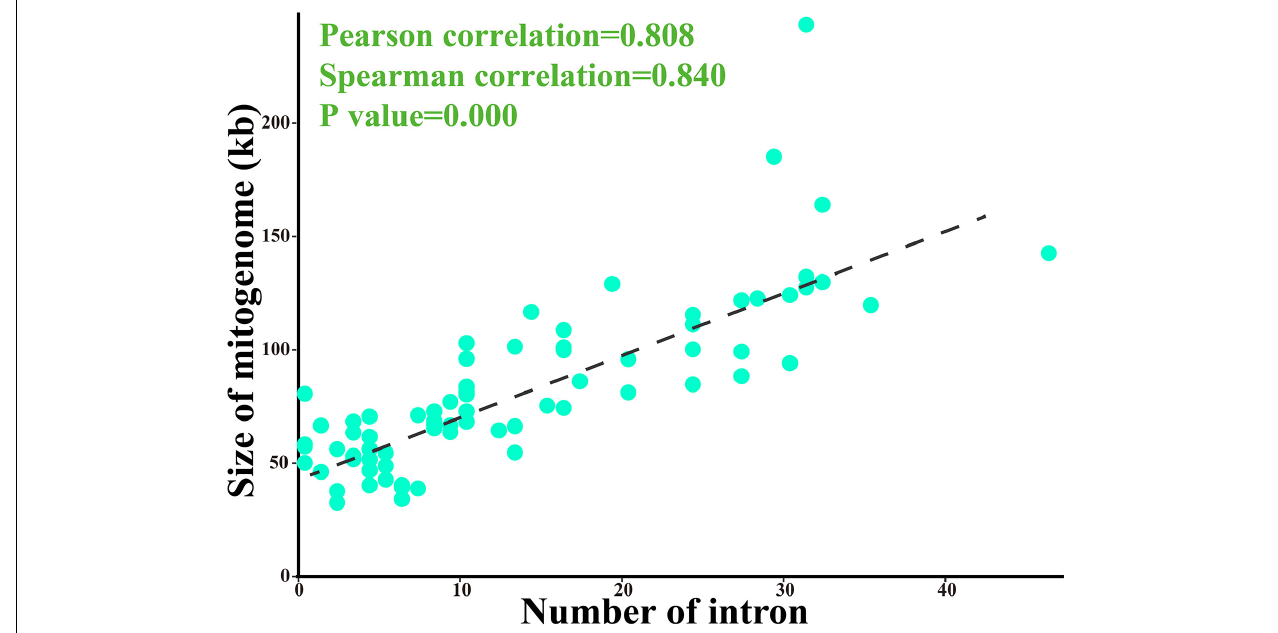
FIGURE 7 | Pearson and spearman correlation analyses of mitogenome size and intron number of 79